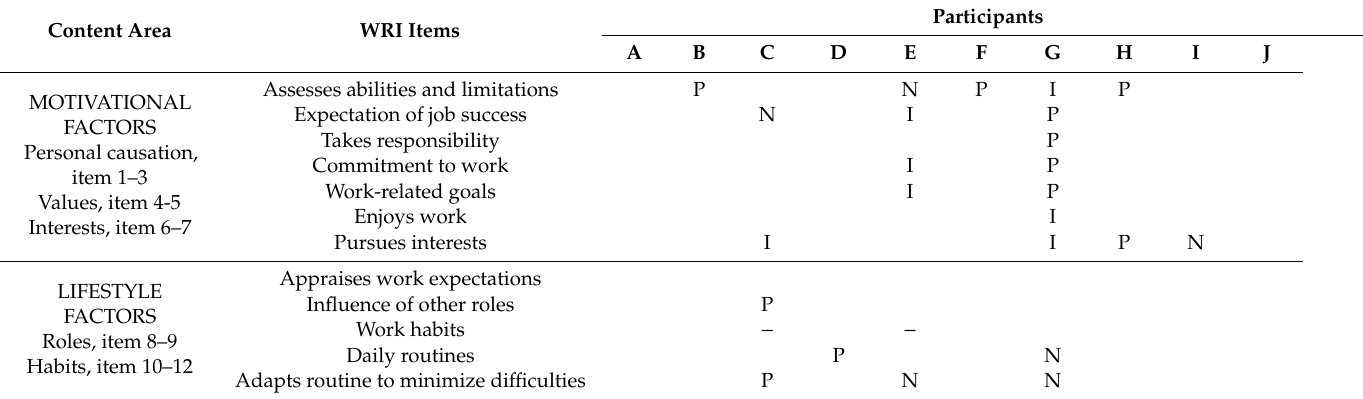
Table 3. Participants’ changes in work potential between baseline and after 3 months of work trial assessed with the worker role interview (WRI). Content